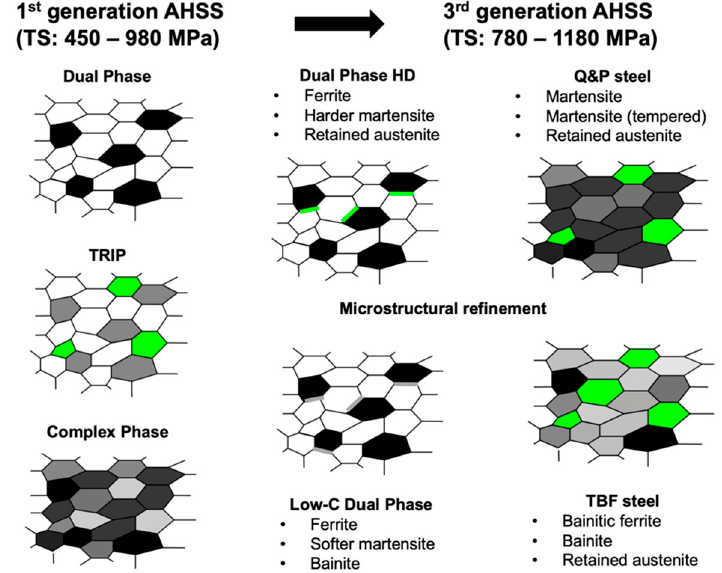
Figure 1. Microstructural evolution of advanced high strength steels for automotive applications (white: ferrite, black: martensite, green: retained austenite, grey: bainite and tempered martensite).